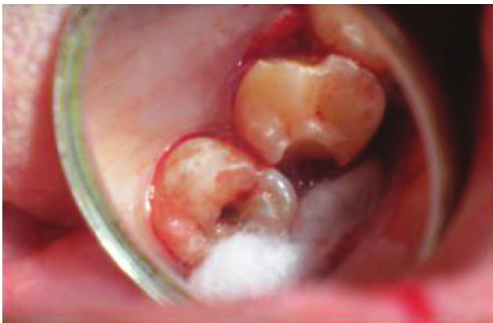
Figure 18: Occlusal view of surgical site of fractured 16 after surface disinfection and application of bonding agent.